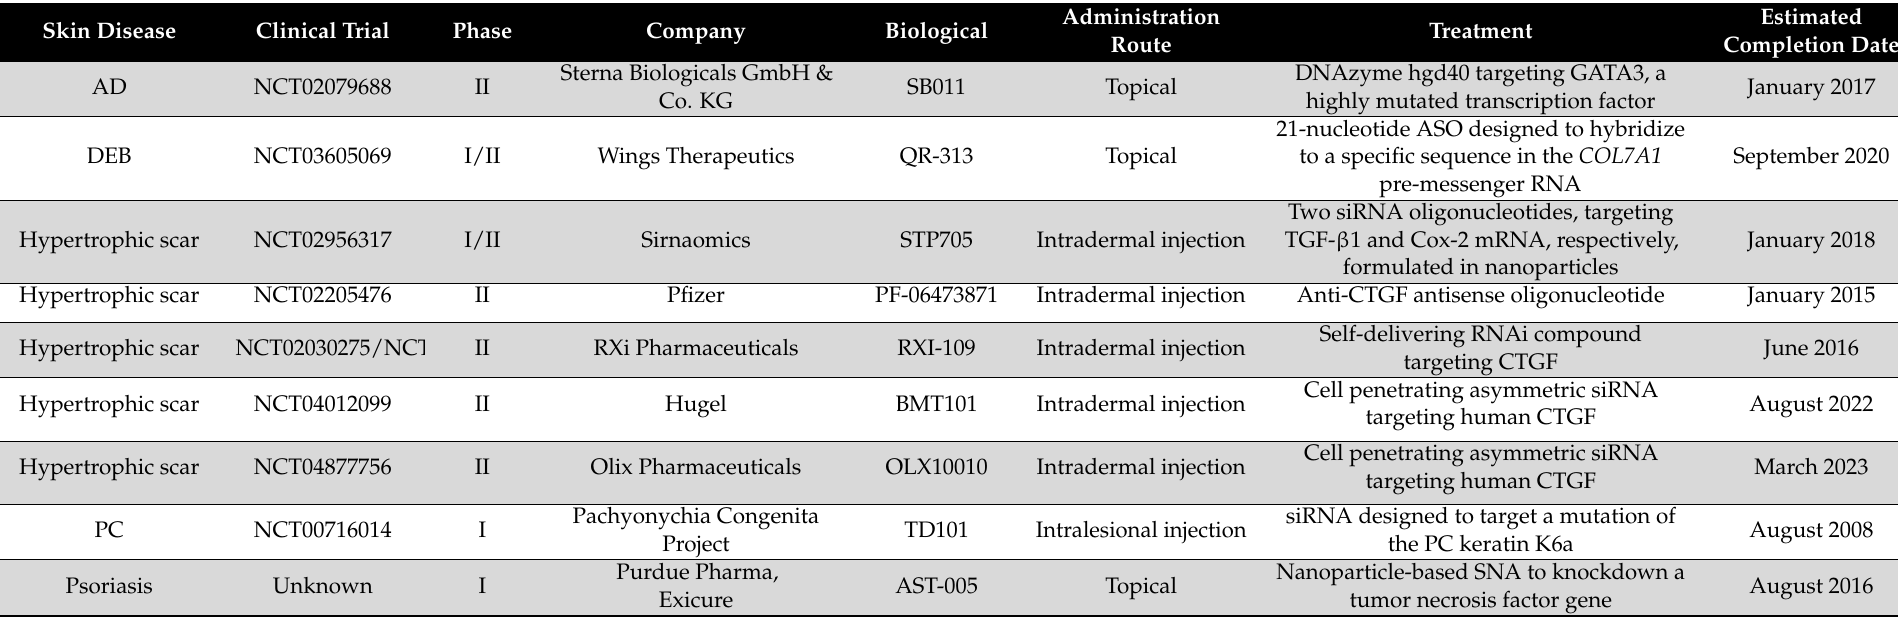
Table 2. Ongoing and completed clinical trials using oligonucleotides to treat dermatological conditions